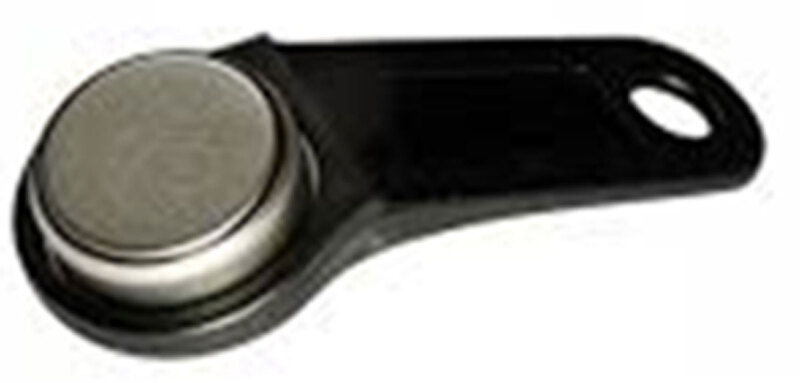
Thermochron i-Button® DS1923 temperature and humidity logger (Source: From Manufacturer).